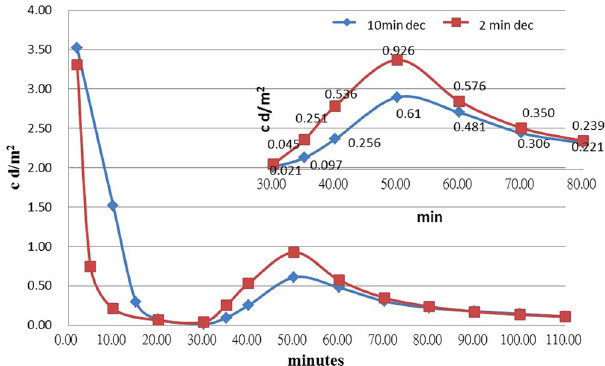
Figure 9. A TL-time plot with two curves with an initial irradiation at 90 °C, which was then decreased to 0 °C after at 2 and 10 minutes for the rectangle and diamond symbol cases